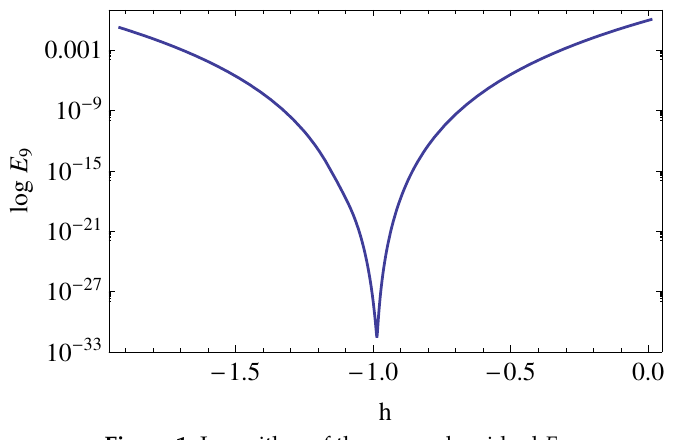
Figure 1. Logarithm of the squared residual E 9 . Table 1. Values of errors of the exact solution reconstruction ( ∆ n = (cid:107) u e − (cid:98) u n (cid:107) 1 ).